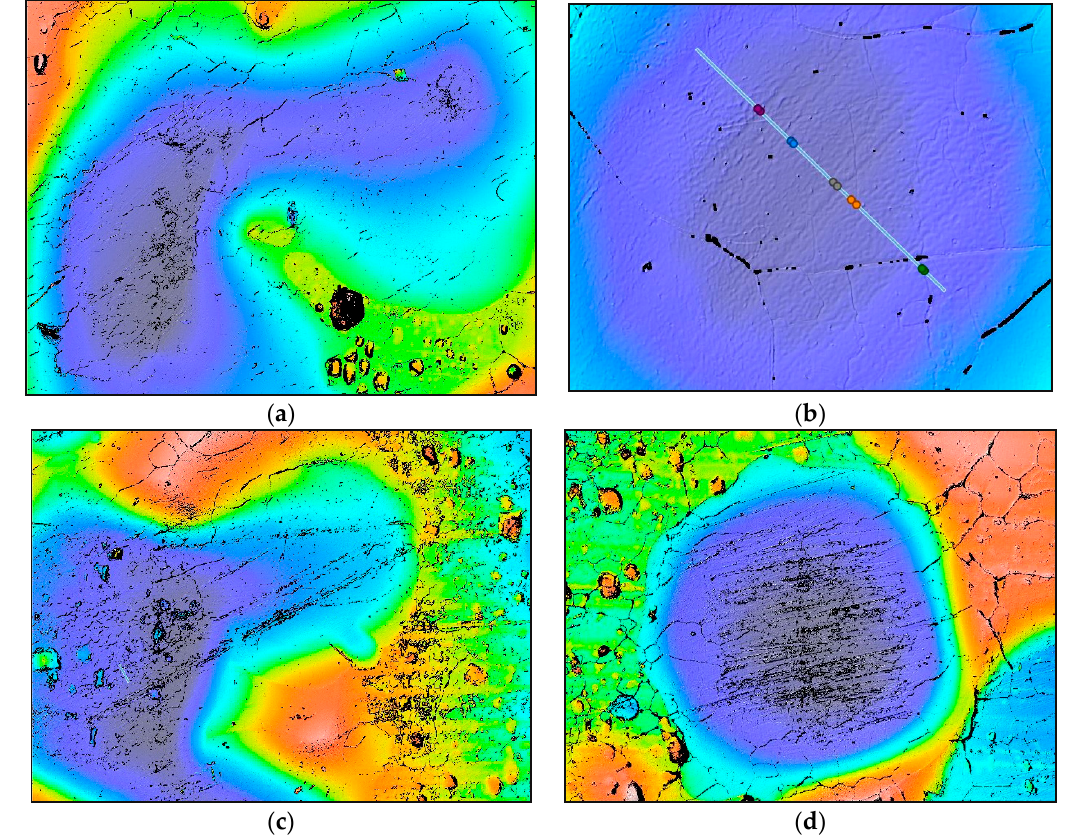
Figure 3. Images from SensoScan software showing ( a ) Nipped pebble with 1 Rock, ( b ) Broom A1, ( c ) Broom C1, and ( d ) Hair